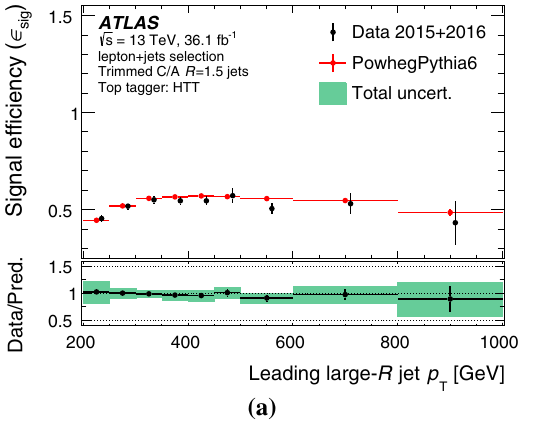
as error bars on the data points and the sum in quadrature of statisti- cal and systematic uncertainties as a shaded band. When considering experimental uncertainties arising from the large- R jet, only those com- ing from the jet energy scale and resolution are considered. The signal efficiencyoncontainedtop-quark jetsfor theHEPTopTagger isnotcon- stant with respect to jet p T as the tagger was not re-optimised after the Run-1 analysis